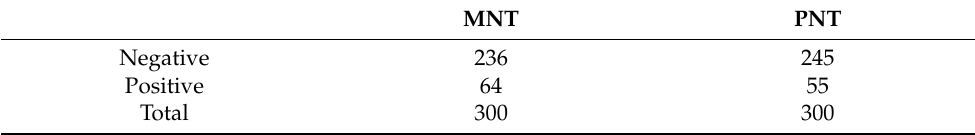
Table 1. Total number of serum samples by MN and PNT.